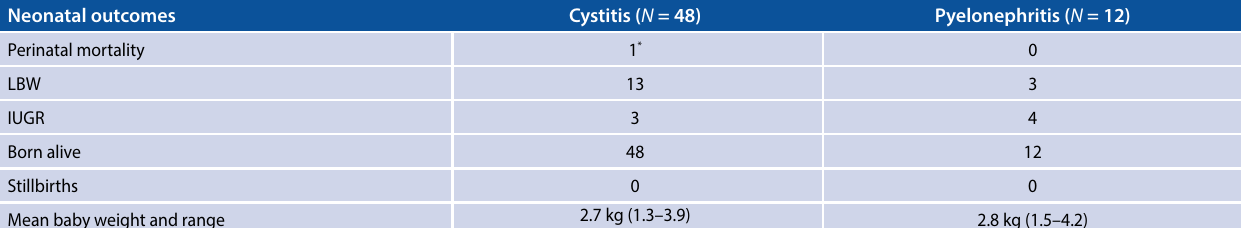
Table 1: Maternal-characteristics